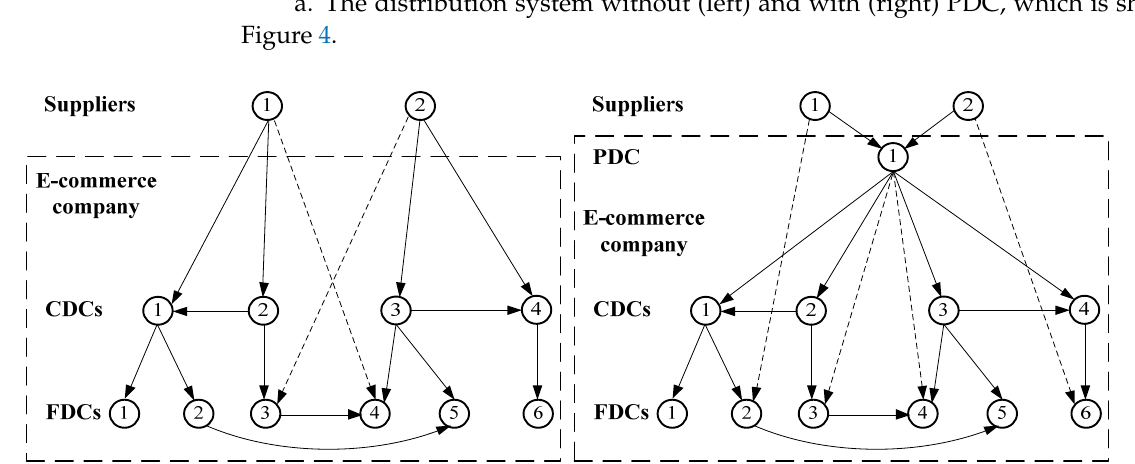
Figure 4. A distribution system without and with PDC.